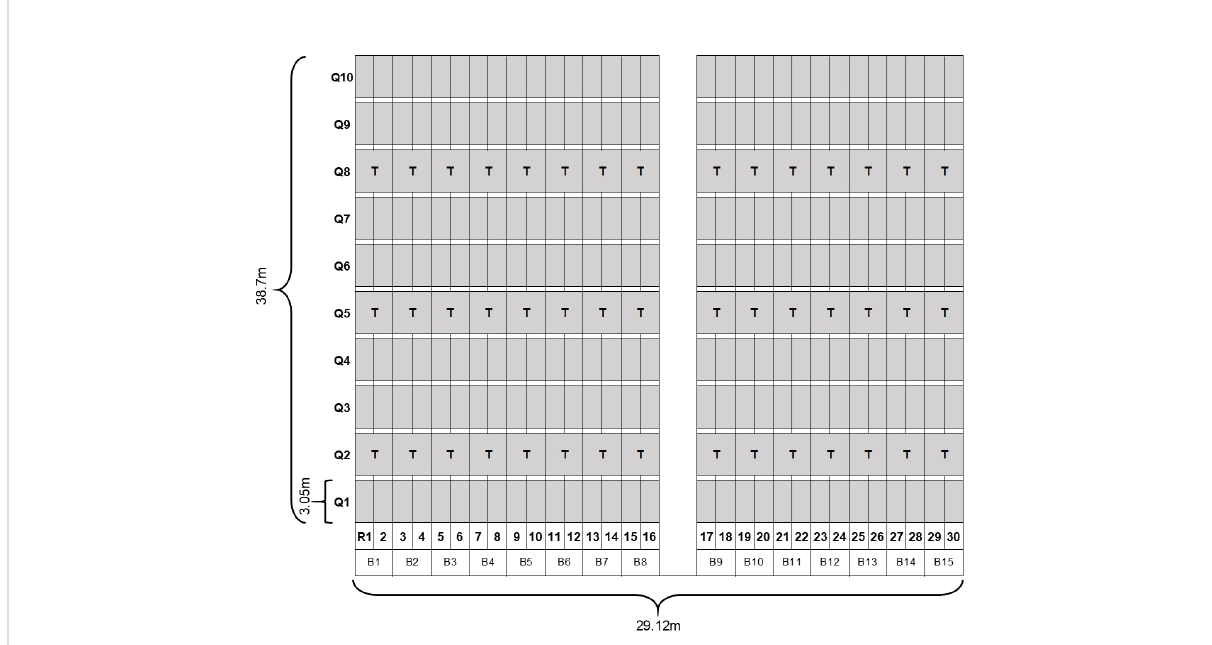
FIGURE 1 Experimental design in fi eld trials conducted in UGA Black Shank Farm. Each gray cell represents a 0.91m x 3.05m quadrat; WTVC incidences were taken per quadrat. Q, quadrats; R, rows; T, indicates where traps were